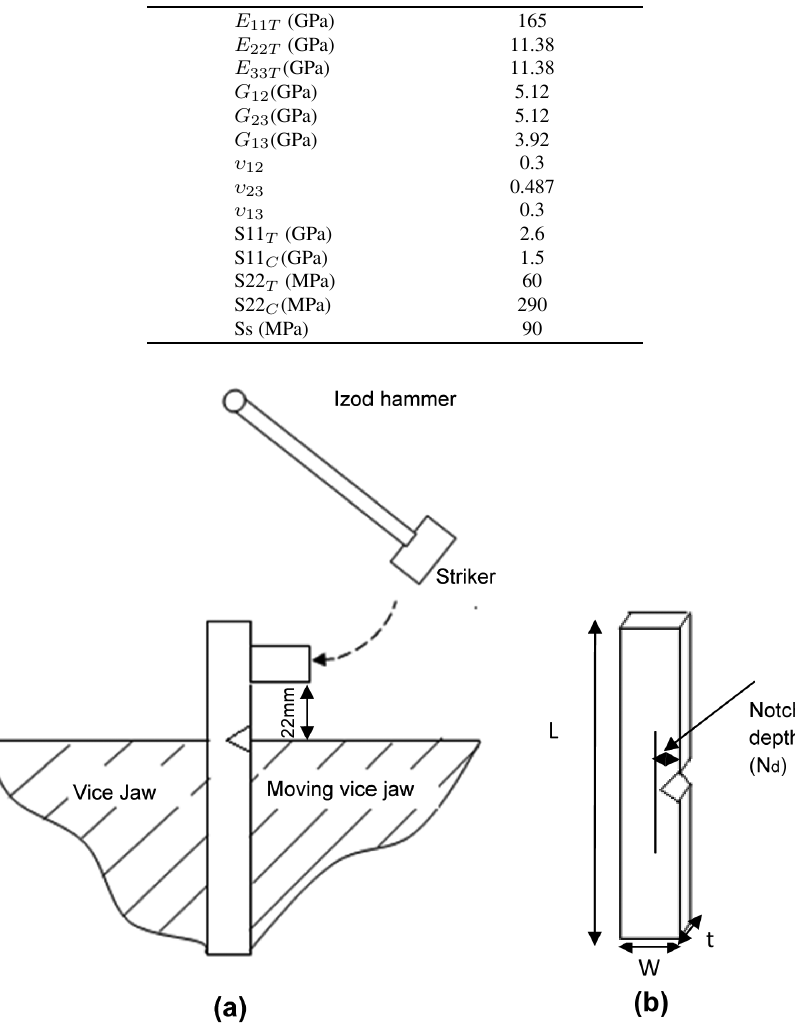
Table 2 Properties of IM7/8552 composite at room